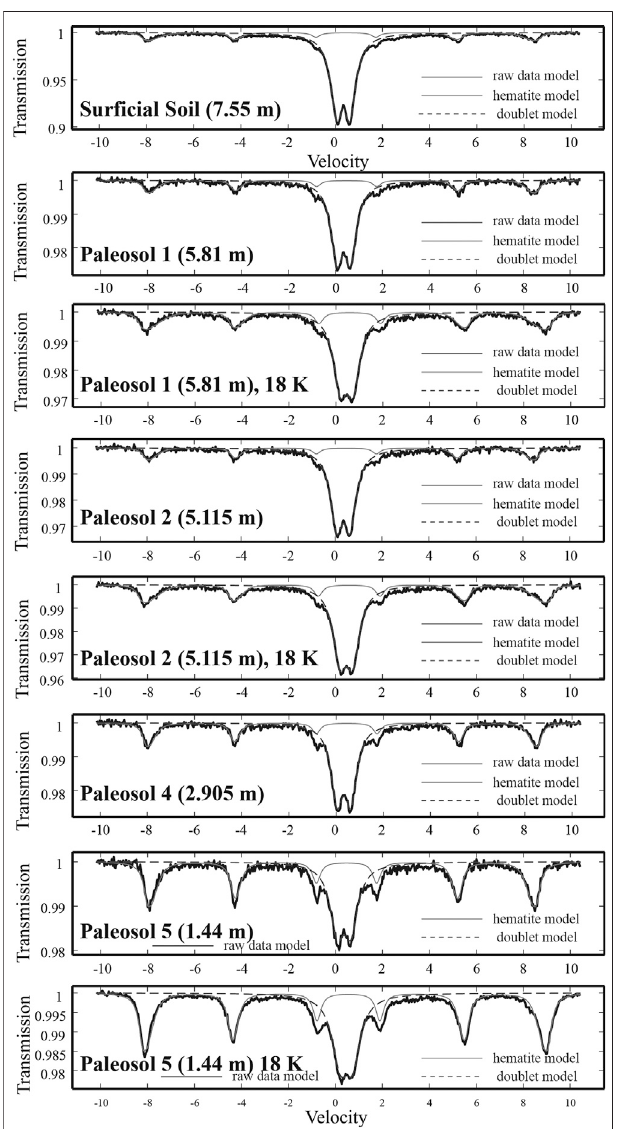
FIGURE 5 | Room temperature Mössbauer spectra of samples from the Sur fi cial Soil, Paleosol 1, Paleosol 2, Paleosol 4, and Paleosol 5; in addition to low temperature spectra of Paleosols 1,2, and 5. Regardless of temperature of the experiments, all spectra can be fi t to a hematite model and a doublet model, the latter indicating paramagnetic material (de Grave and Vandenberghe, 1990; Vandenberghe et al., 2000; Zhi et al., 2000; de Grave et al., 2002; Jele´nska et al., 2010; Necula et al.,